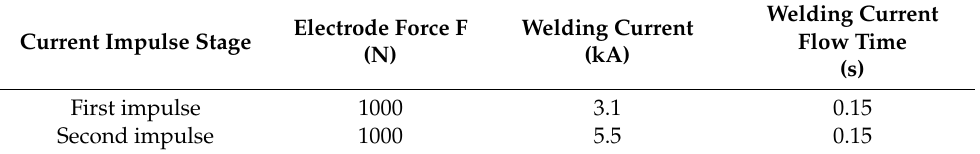
Table 6. The selected parameters of the welding